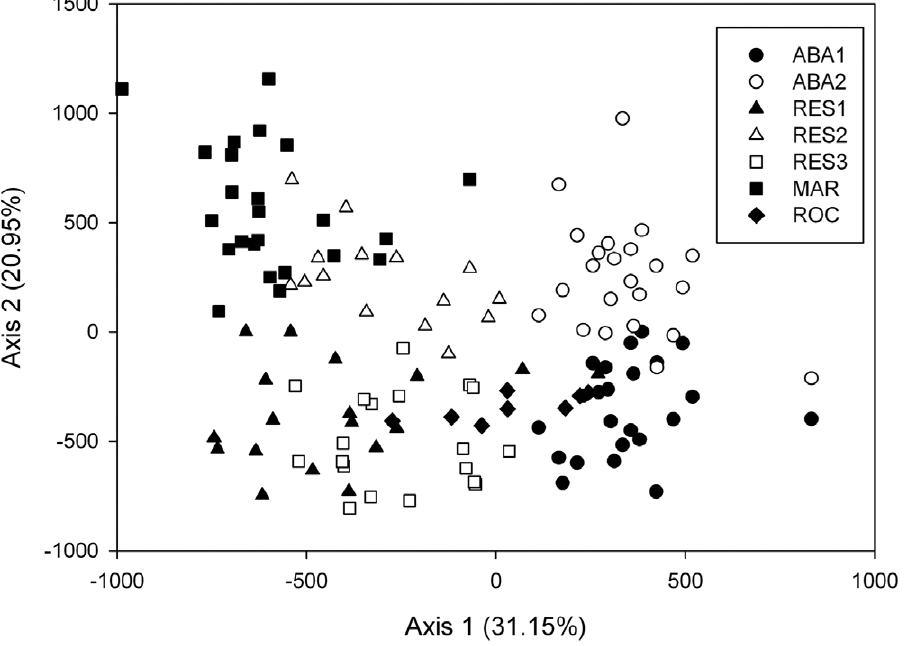
Figure 2. Regression of interpopulation genetic distances ( F ST ). Pairwise comparisons inferred with microsatellites and mitochondrial Control Region after calibration (see text) are noted with filled circles (solid line) and open circles (dashed line), respectively, on the natural logarithm of geographic distance among populations. Equation of microsatellites regression: y=0.108 + 0.018x. Equation of Control Region regression: y= 2 0.415 + 0.057x.